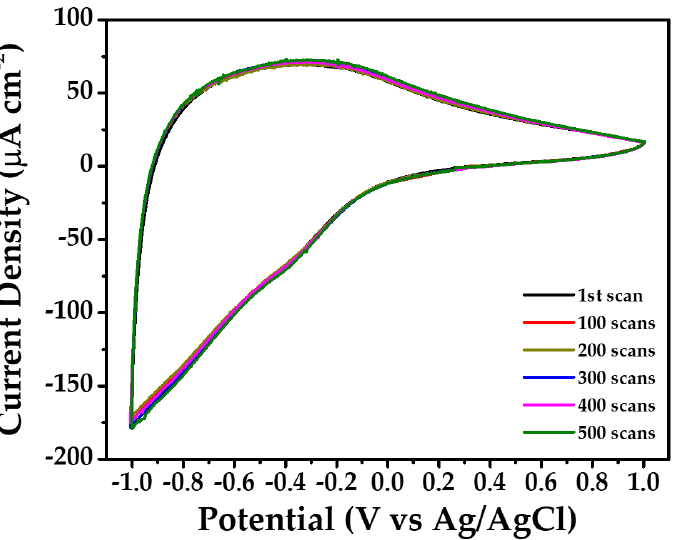
Figure 5. Multiple cyclic voltammetry experiments (scans) of WO 3 film with 0.1 M (5 mL) at a scan- ning speed of 10 mV sec − 1 (stability experiment).